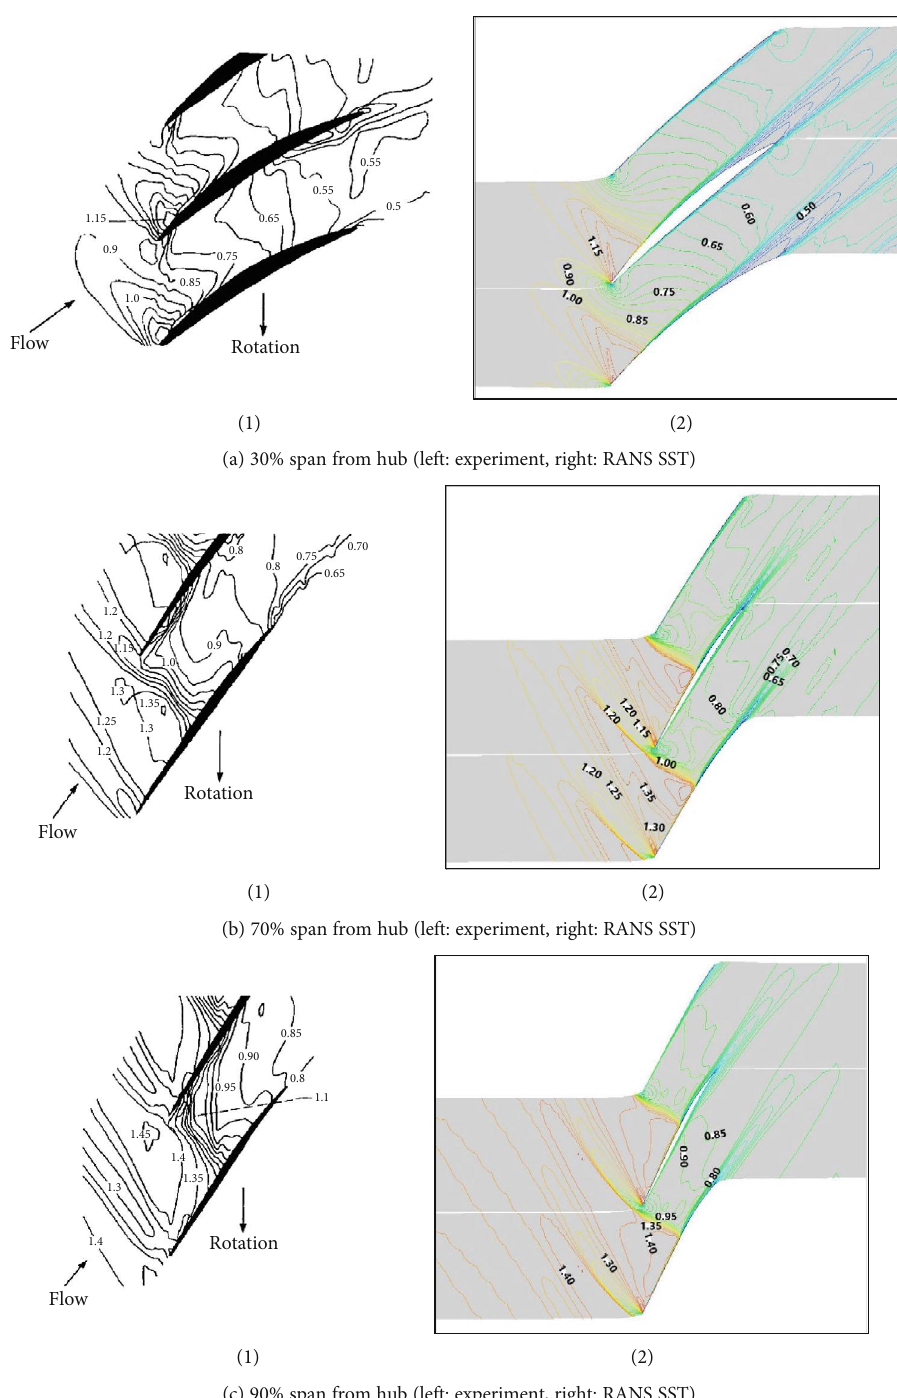
Figure 9: Comparisons of predicted and measured relative Mach number at three typical blade heights for near stall